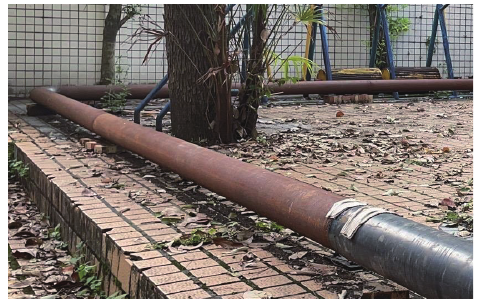
Figure 15. Actual view of the experimental